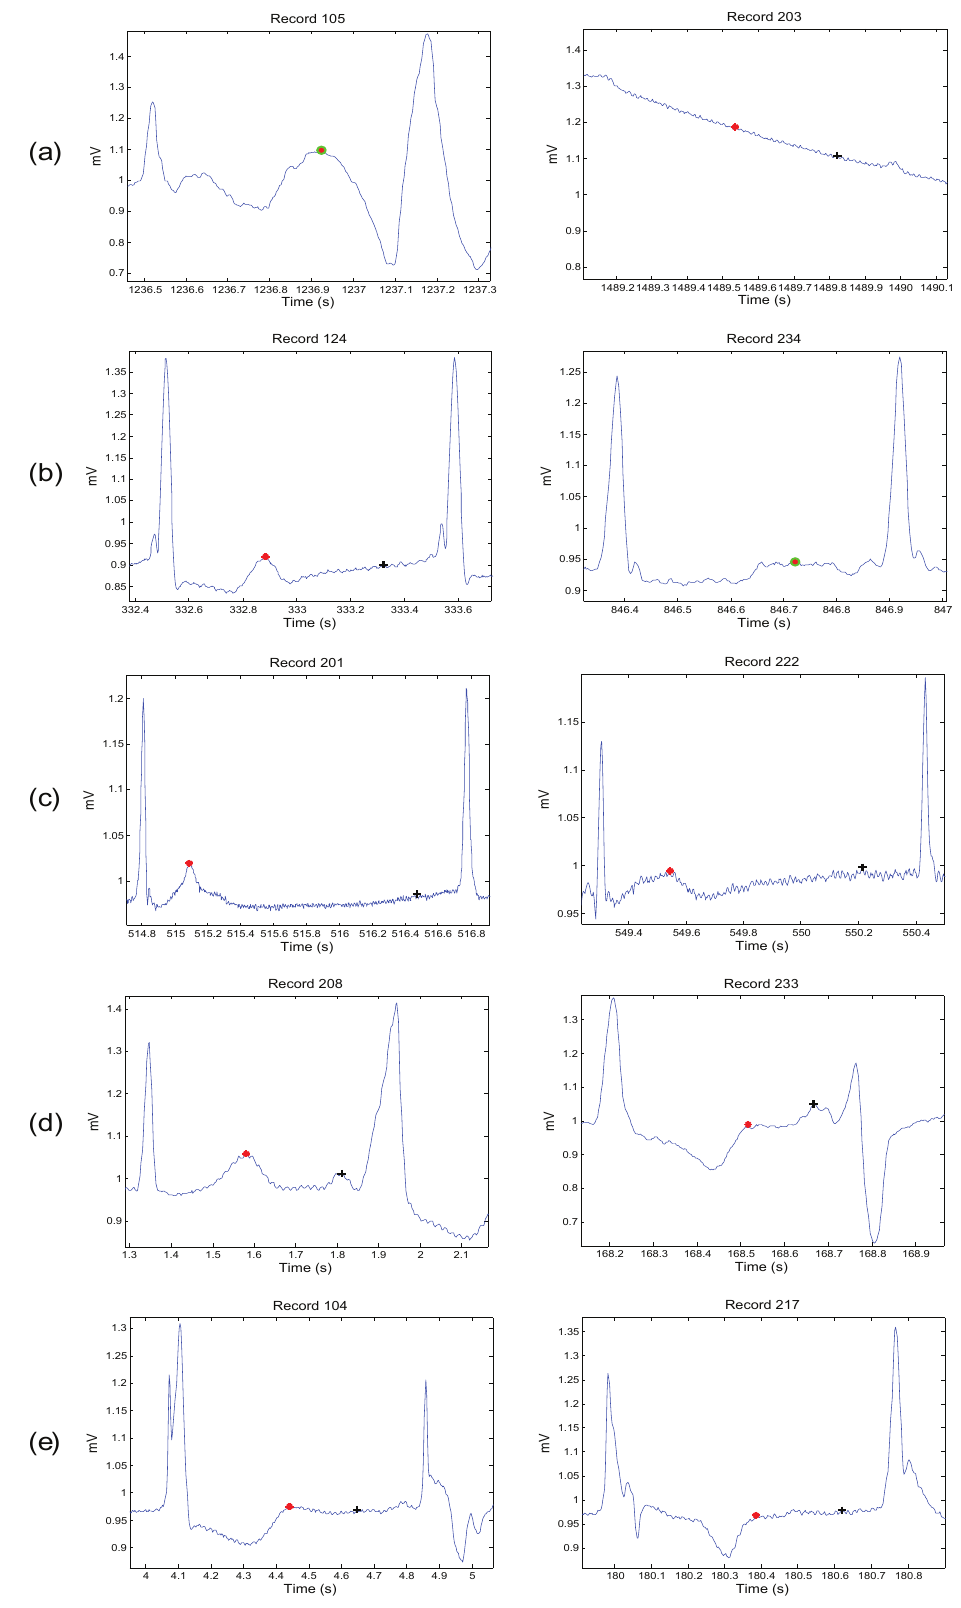
Figure 3. Annotation of P and T waves in unusual beats. Each row contains two different morphologies for a certain type of unusual beats: ( a ) unclassified beats; ( b ) nodal premature beat; ( c ) nodal escape beat; ( d ) fusion of ventricular and normal beat; ( e ) fusion of paced and normal beat. Here, “+” represents the P wave and “*” represents the T wave, while the green circle with asterisk represents merged P and T